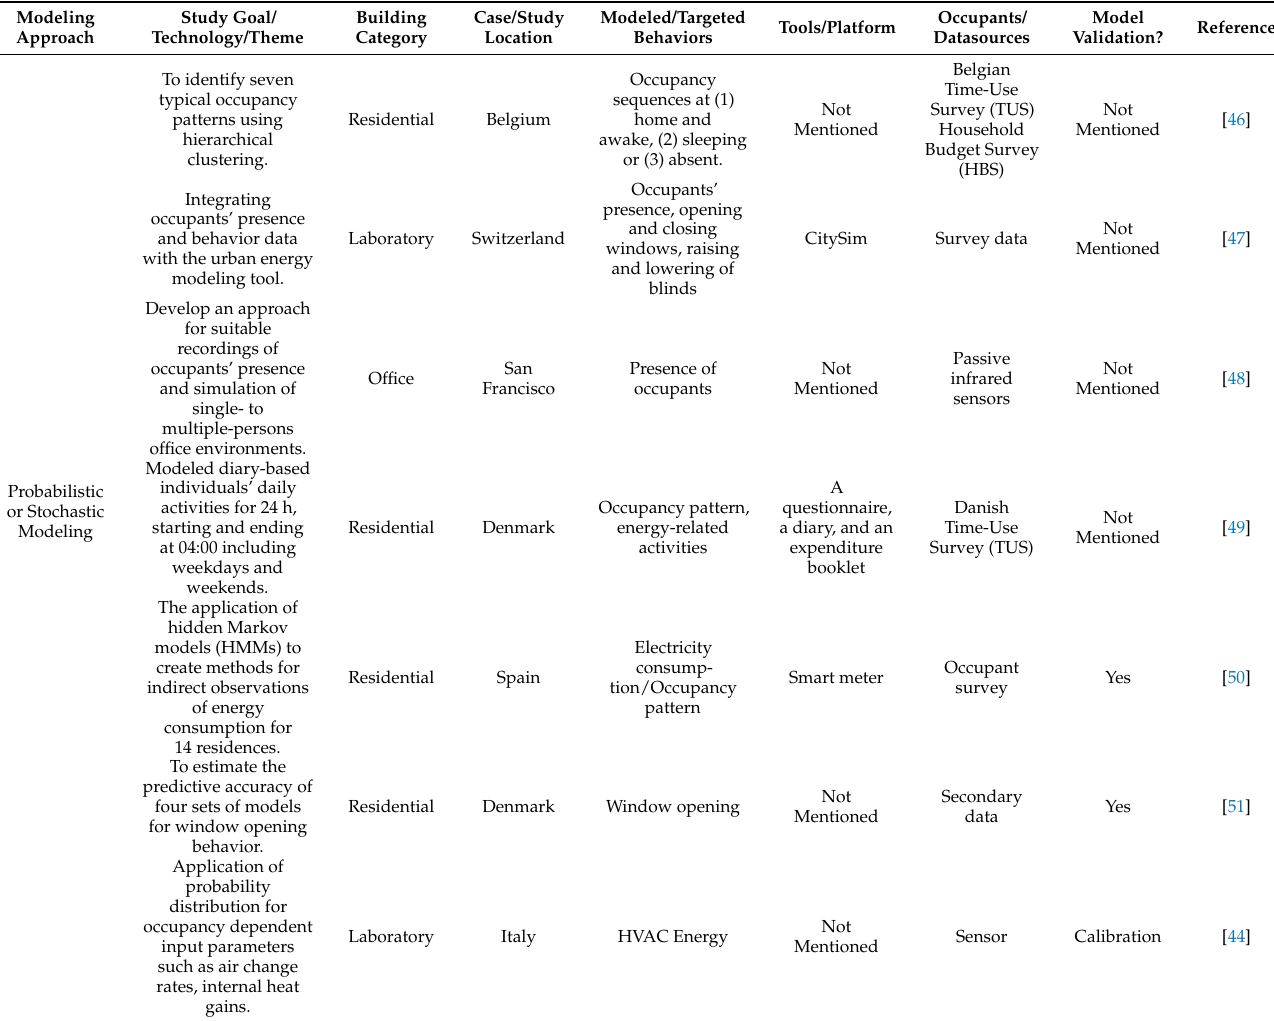
Table 1. List of quantitative modeling for building occupant behavior